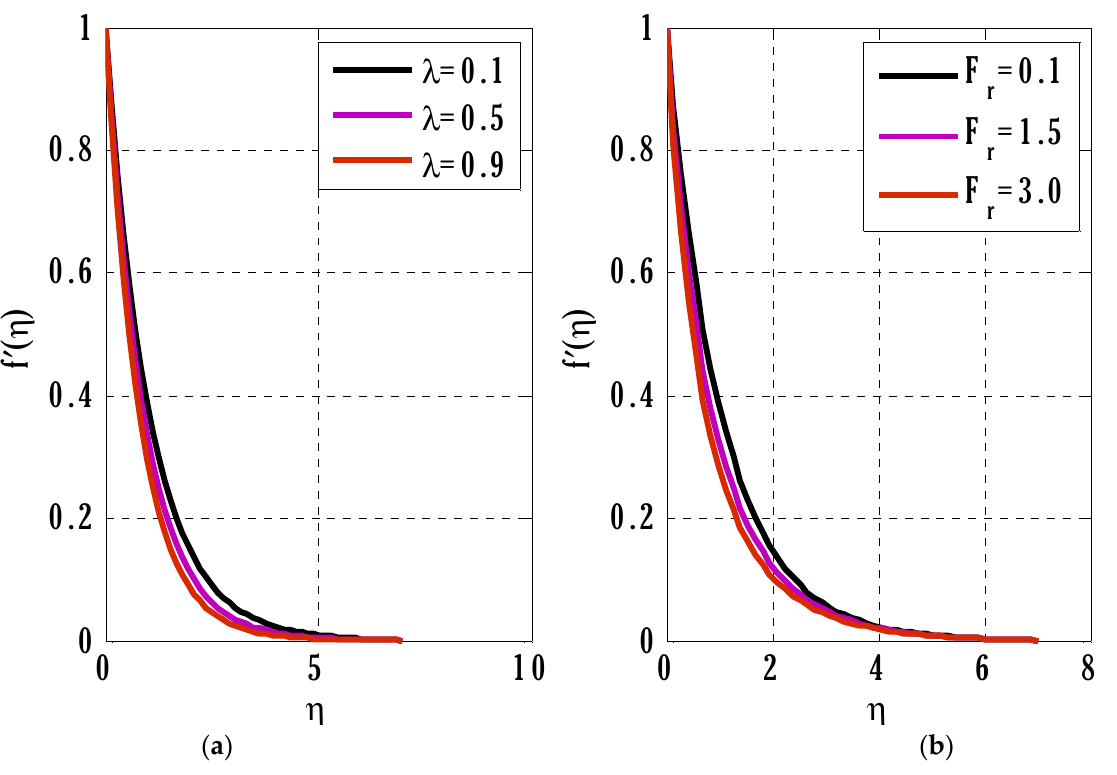
Figure 2. Variation of porosity parameter and inertia coefficient on velocity profile using M = 0.1, E 1 = 0.01, β = 3. ( a ) F r = 0.1 ( b ) λ = 0.1.